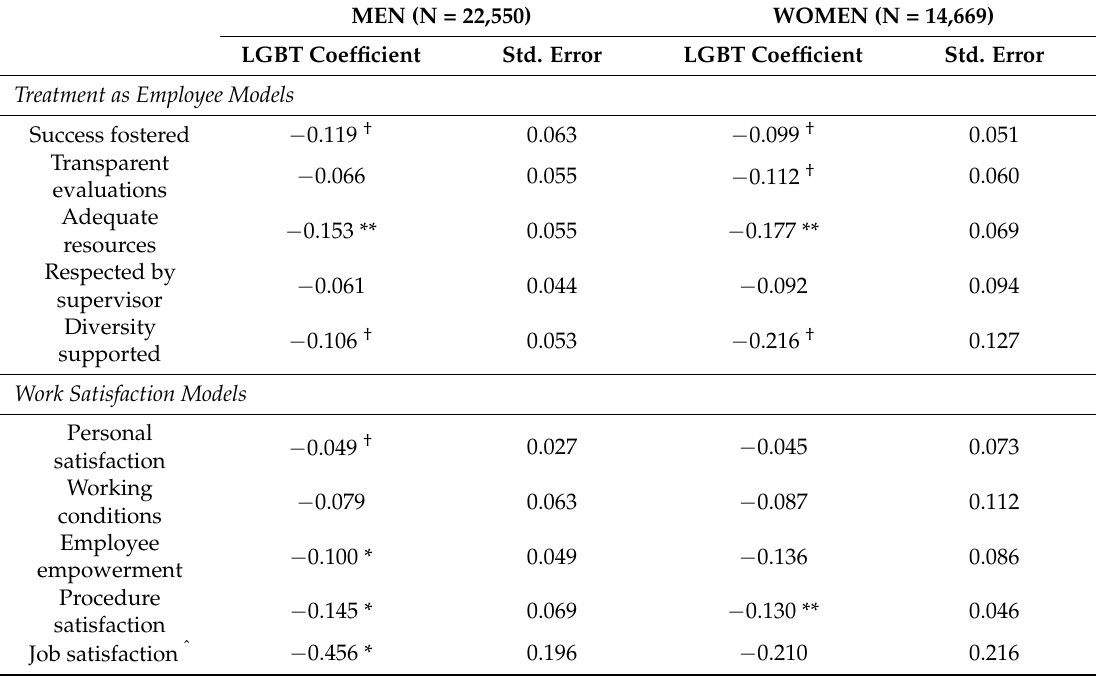
Table 6. OLS and Ordered Logistic Regression Models Predicting Workplace Experience Measures with LGBT Status, Run separately for Women and